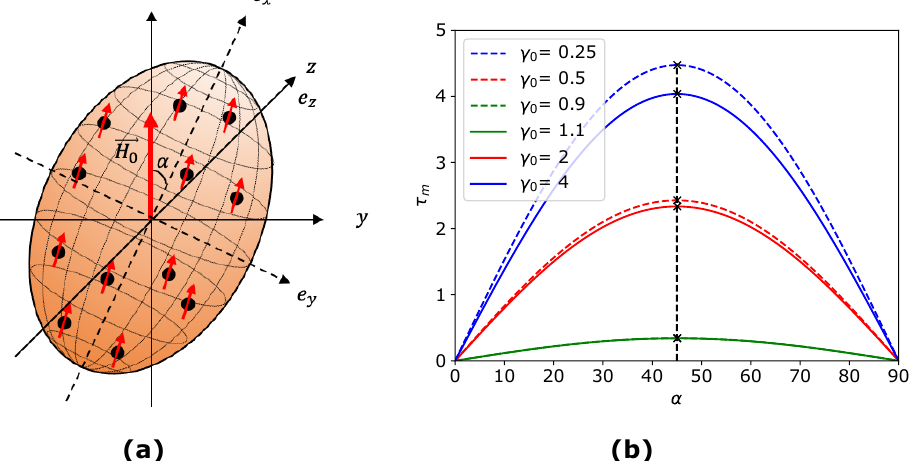
Figure 2. ( a ) A prolate MAE suspended freely in a uniform magnetic field (cid:126) H 0 applied along the x -axis. | τ xy | as a function of a rotation angle α ( b ) The dimensionless magnetic torque τ m = 1 ζ